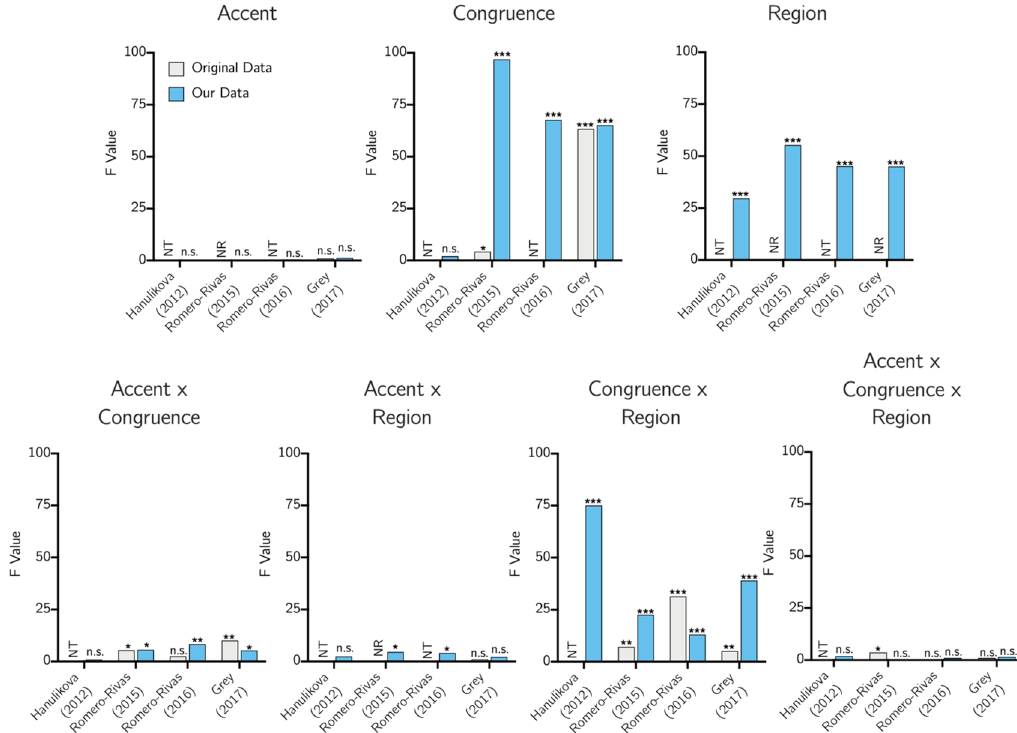
Figure 2. A graphical representation of F values for each main effect and interaction in the N400 time range found using each parameter set, either as reported in the original study (“original data”) or using our data (“our data”). Stars indicate significance (* p < 0.05, ** p < 0.01, *** p < 0.001), “n.s.” indicates not significant at p < 0.05, “NR” indicates the main effect or interaction was tested in the original study but a significant result or F